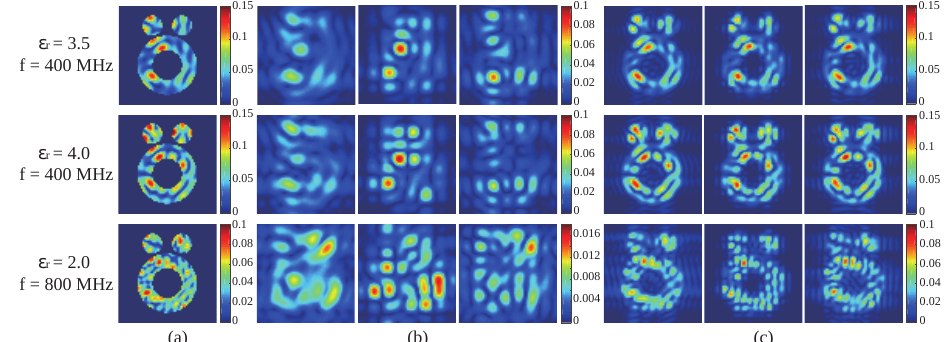
Figure 3. ( a ) The modulus of the induced currents in the domain of interest (DOI) at the 0 ◦ incidence. ( b ) The 1st, 2nd, and 3rd columns correspond to approximation results by using 64 low-frequency Fourier components, 3-level bior3.5 wavelet approximate components, and 3-level db20 wavelet approximate components, respectively. ( c ) The 1st, 2nd, and 3rd columns correspond to approximation results by using 256 low-frequency Fourier components, 2-level bior3.5 wavelet approximate components, and 2-level db20 wavelet approximate components,